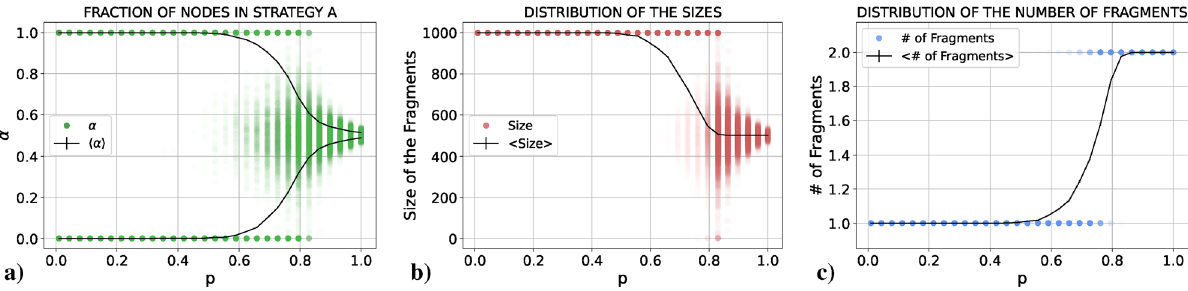
Figure 1. Results for ( a ) α , ( b ) the size and ( c ) the number of fragments (single realizations in green, red and blue, respectively, and average values in black) as a function of p for a PCG played in an E–R network with � k � = 30 using the RD update rule.